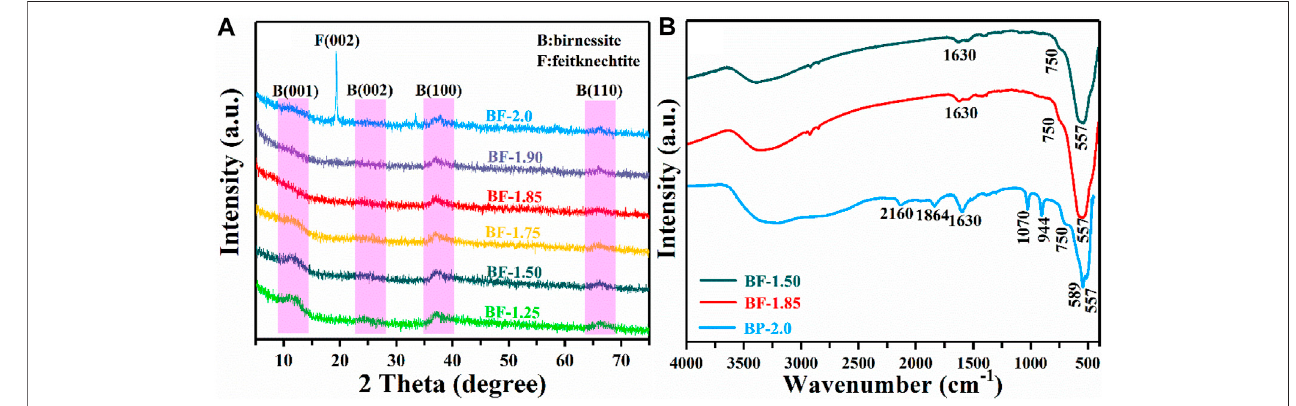
FIGURE 2 | (A) XRD and (B) FTIR patterns of as-prepared samples.